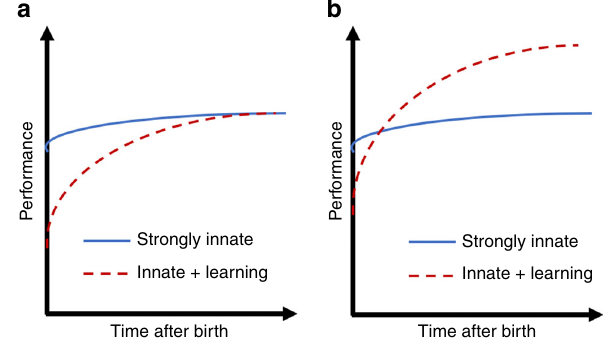
Fig. 2 Evolutionary tradeoff between innate and learning strategies. a Two species differ in their reliance on learning, and achieve the same level of fi tness. All other things being equal, the species relying on a strongly innate strategy will outcompete the species employing a mixed strategy. b A species using the mixed strategy may thrive if that strategy achieves a higher asymptotic level of